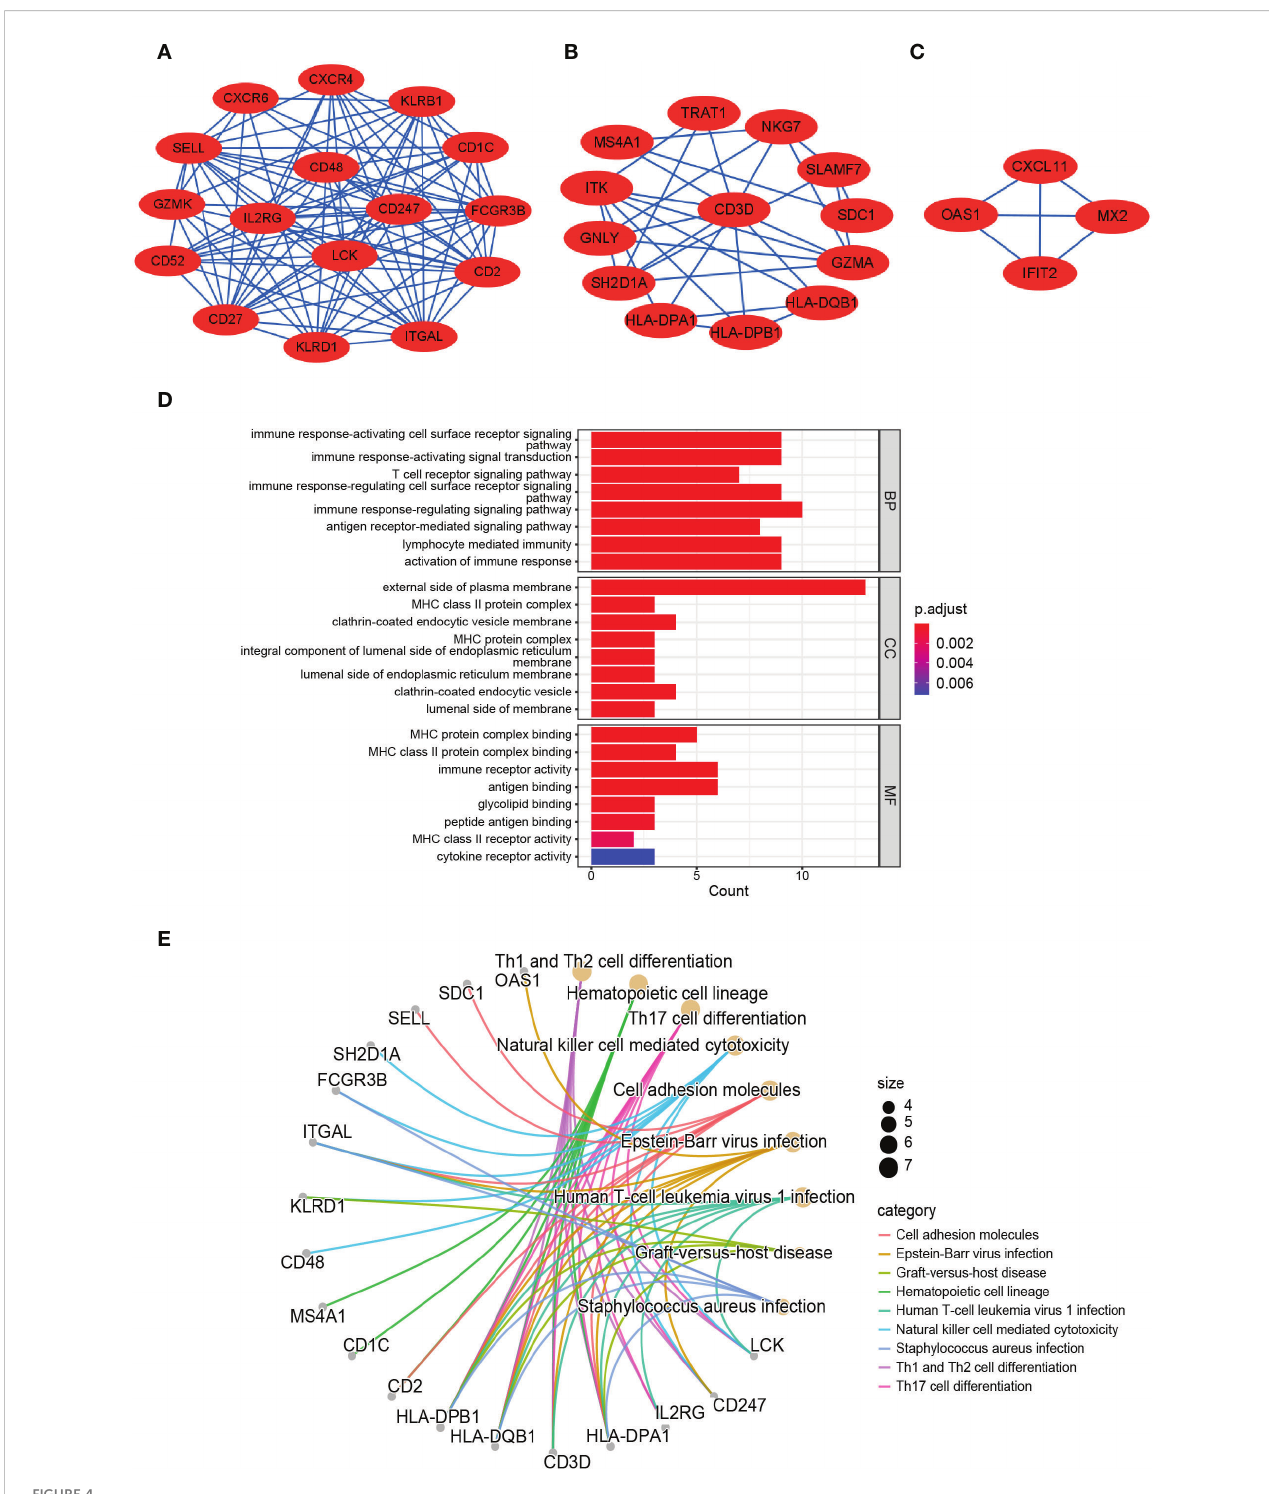
FIGURE 4 TOP 3 closely connected gene modules and enrichment analysis of the modular genes. (A – C) Three signi fi cant gene clustering modules. (D) Barplot of GO enrichment analysis of the modular genes. (E) Circular path diagram of KEGG enrichment analysis of the modular